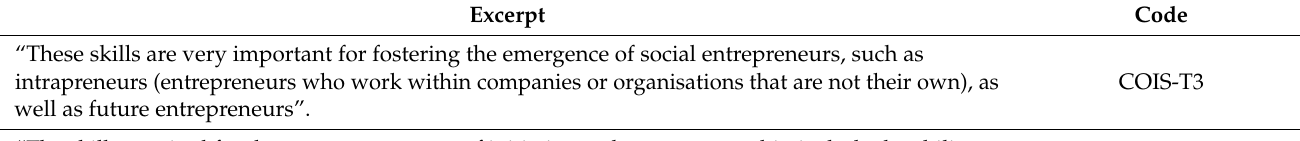
Table 5. Selected excerpts on the topic of competence, sense of initiative, and entrepreneurship.